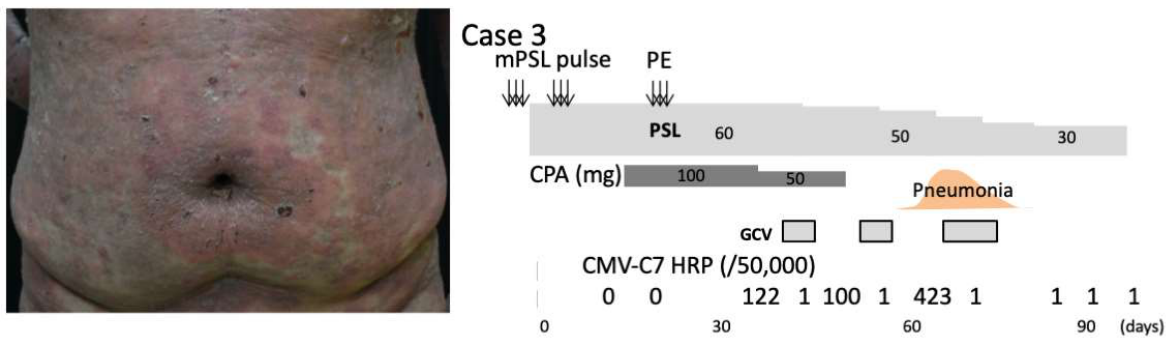
Figure 3. Case 3: Erythema caused by BP and its clinical course. CMV antigenemia developed following pulse therapy and plasma exchange, and the patient developed pneumonia.